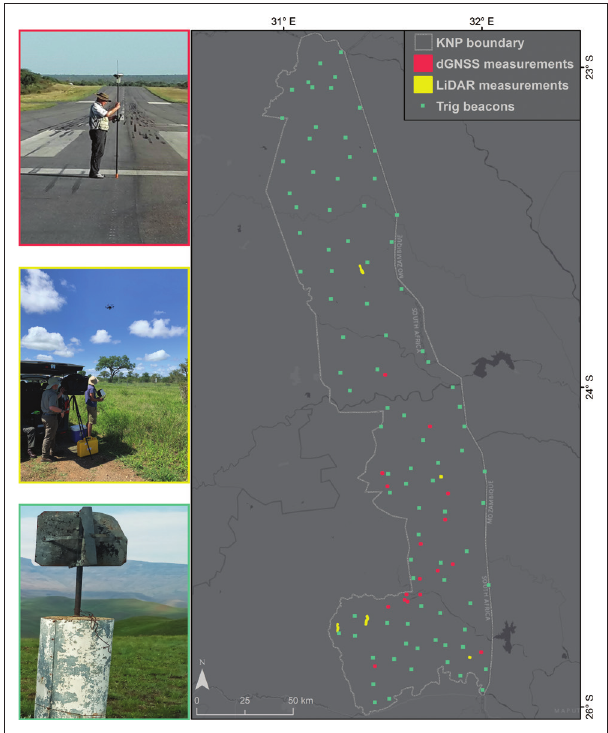
FIGURE 2: Distribution of reference data sets used to validate the elevation models for Kruger National Park, South